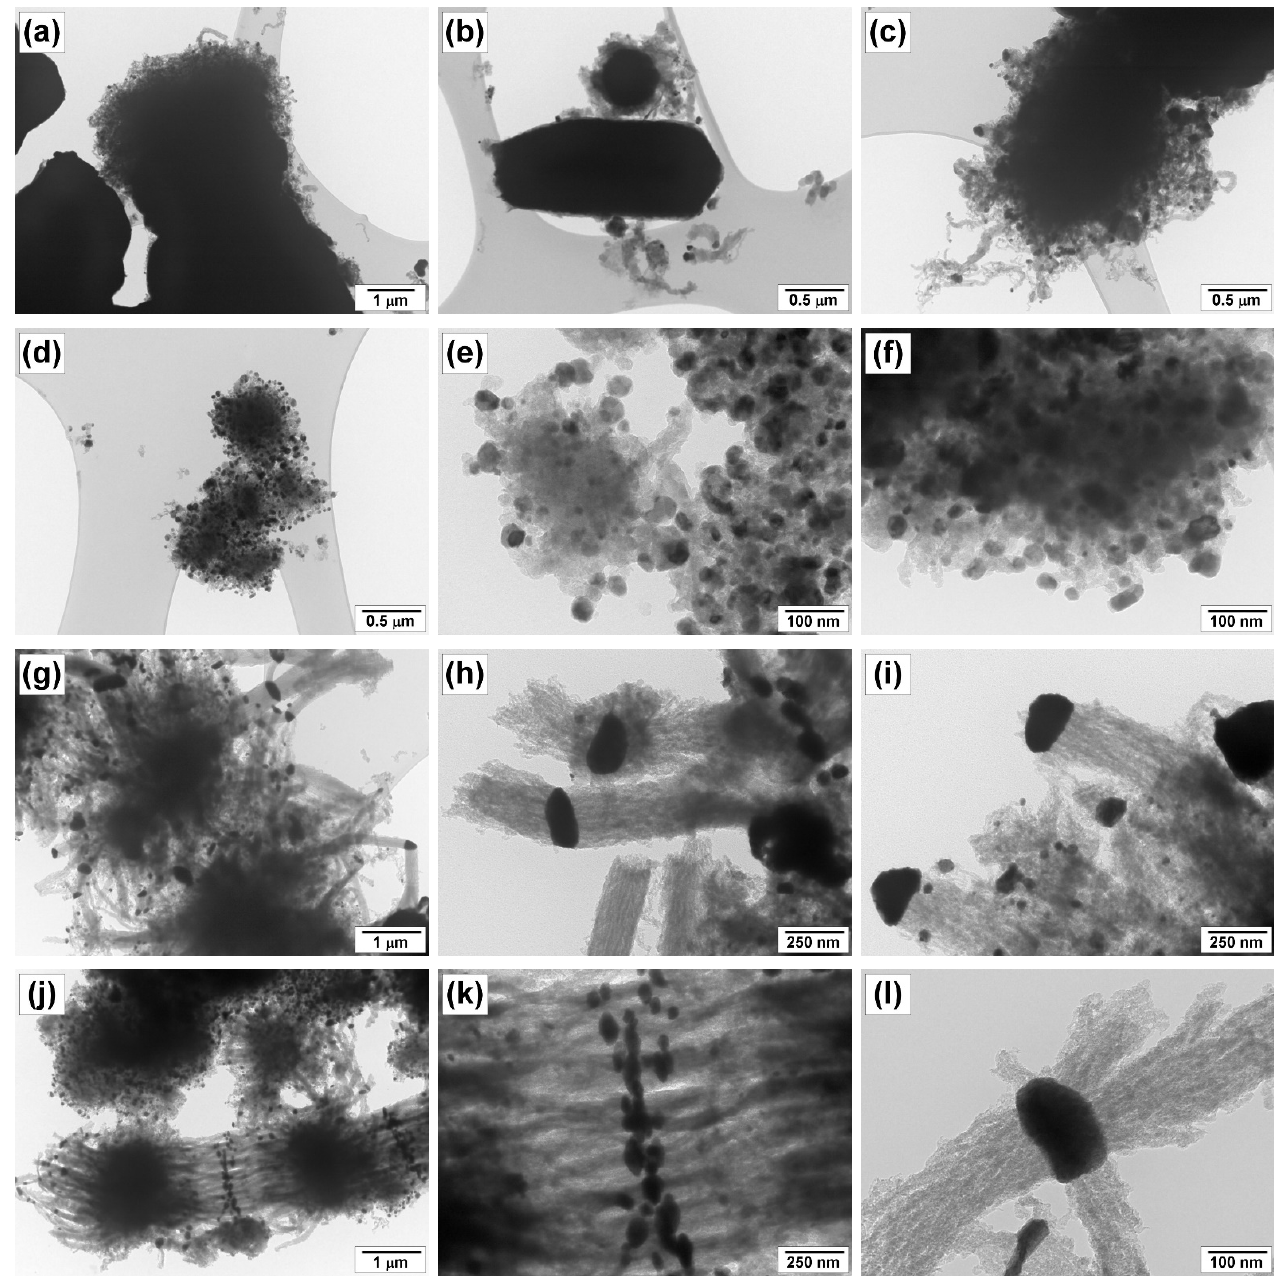
Figure 5. TEM images of the carbon nanomaterials and the catalytic particles formed as a result of carbon erosion of 96Ni-4W alloy during its interaction with TCE at 500 ◦ C for 2 min ( a – c ), 5 min ( d – f ), 10 min ( g – i ), and 15 min ( j – l